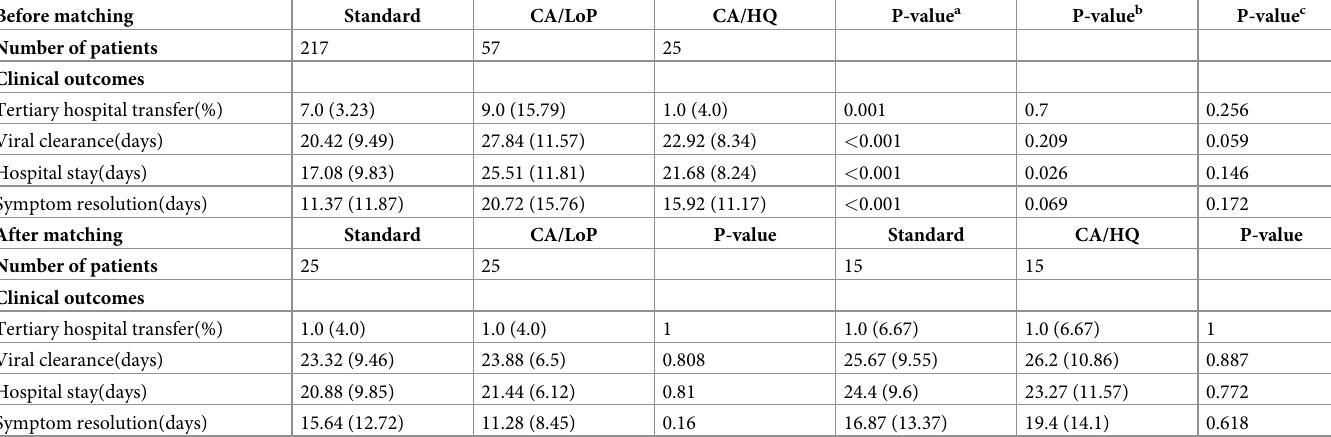
� for ICU admission, Psychiatric problem, failure to negative conversion of viral load before the closure of the hospital. P-value a , p-value b , and p-value c respectively represent test results of Standard vs CA/LoP groups, Standard vs CA/HQ groups, and CA/LoP vs CA/HQ groups. P-values of continuous variables are based on t-test and p-values of categorical variables are based on chi-square